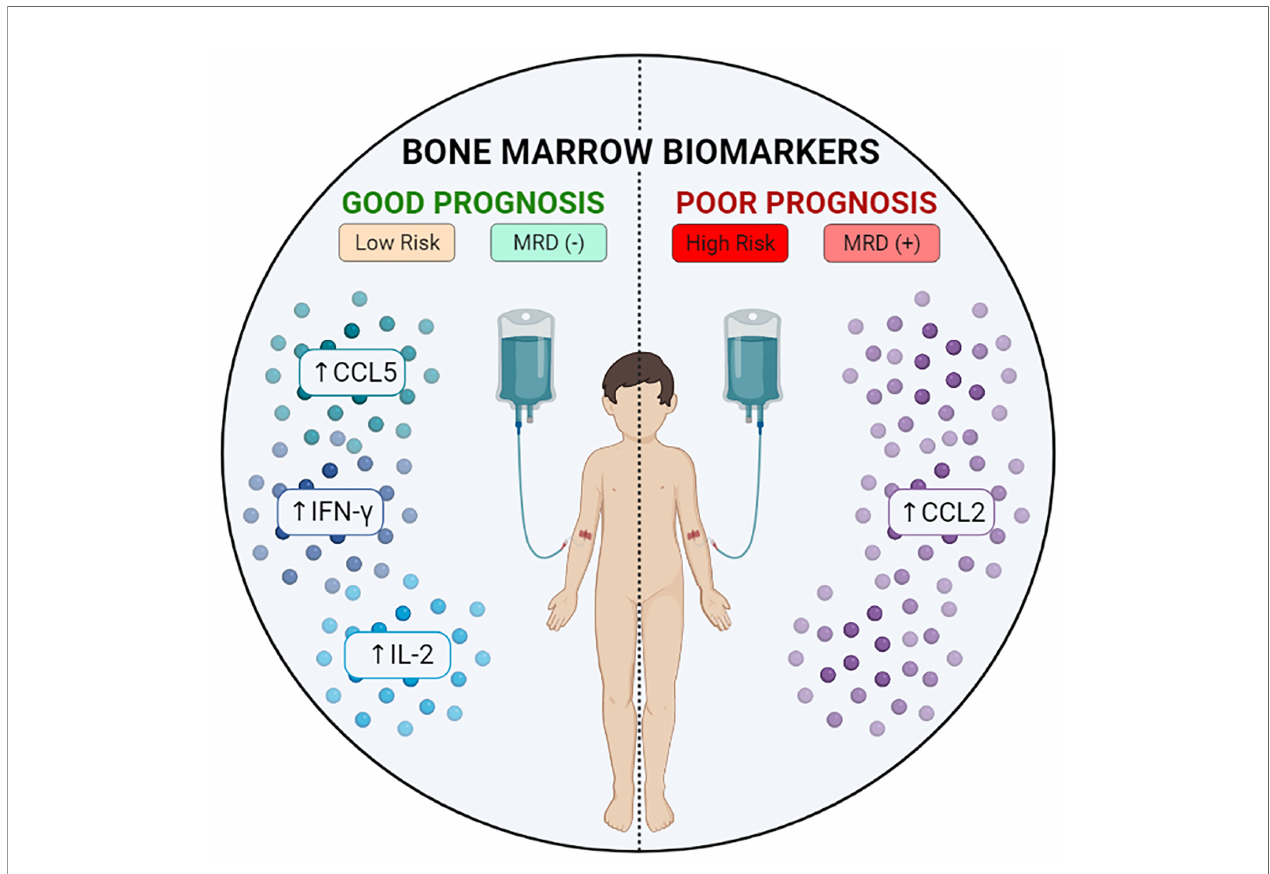
FIGURE 7 | Potential bone marrow biomarkers during induction therapy. Schematic presentation summarizing the biomarkers of good or bad prognosis identi fi ed in the